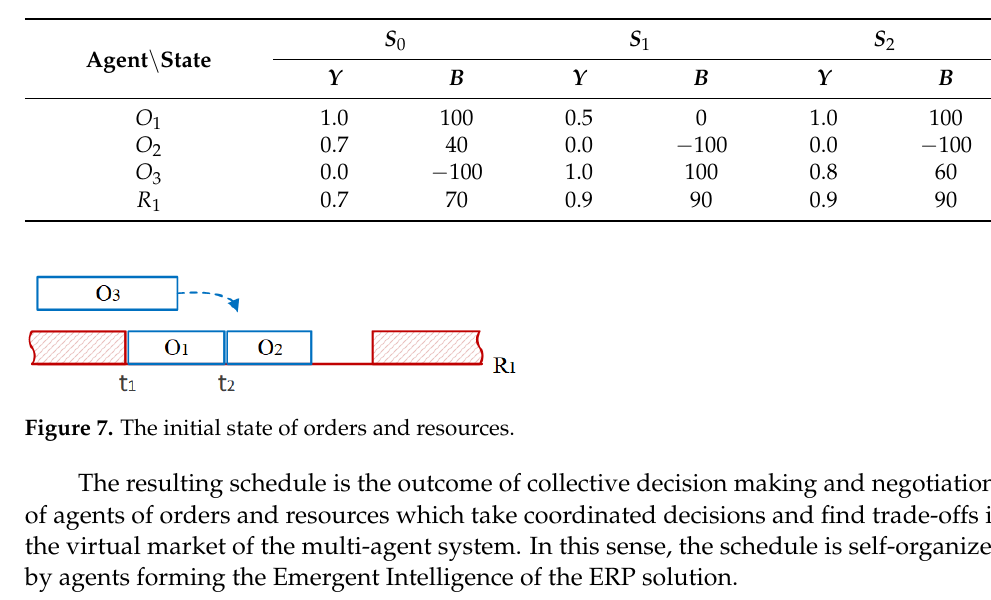
Figure 4. Fragment of negotiations of demand agent. Figure 7. A fragment of agent negotiation aimed at resolving conflicts. Table 7. The satisfaction and budget of agents in different states.